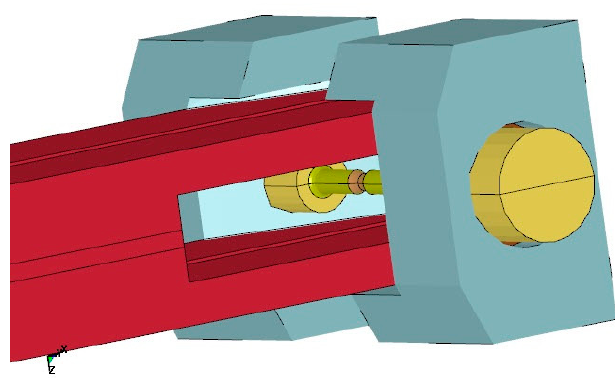
Figure 7. A view of 3-D model of the Flying Wedge